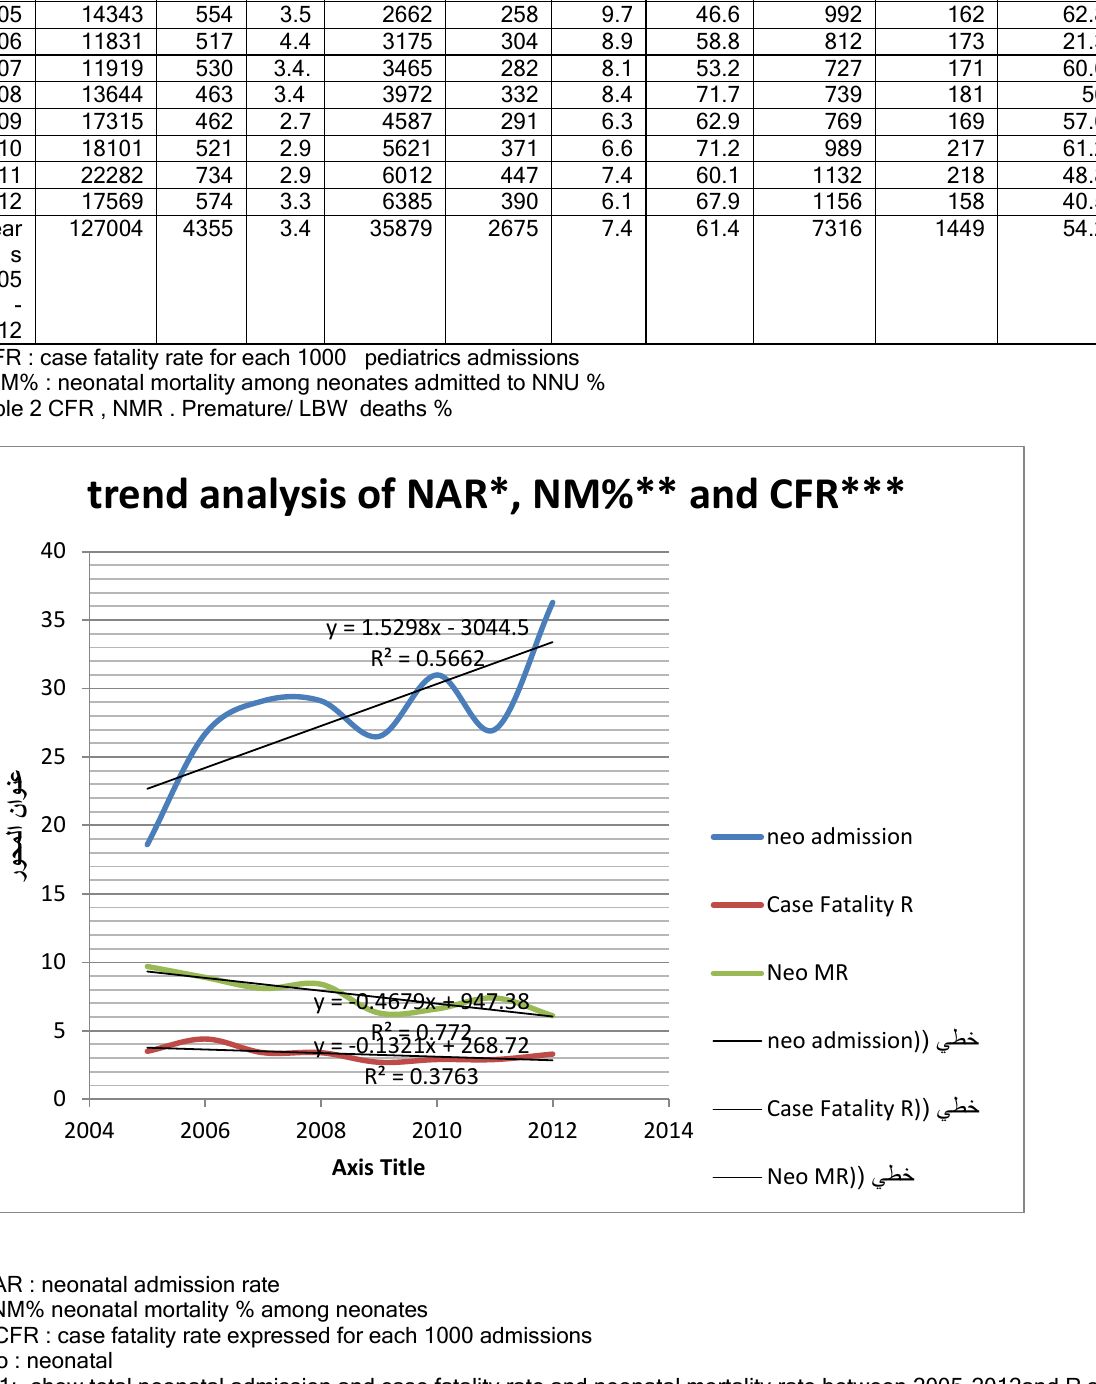
Fig1;- show total neonatal admission and case fatality rate and neonatal mortality rate between 2005-2012and R square* of each as trend analysis